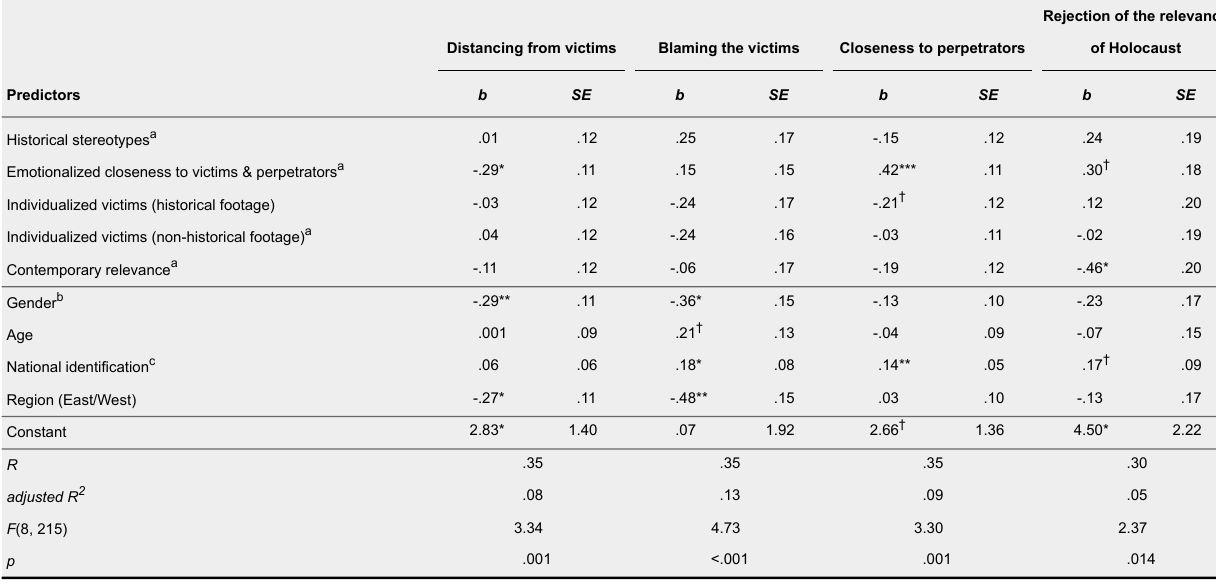
Rejection of the